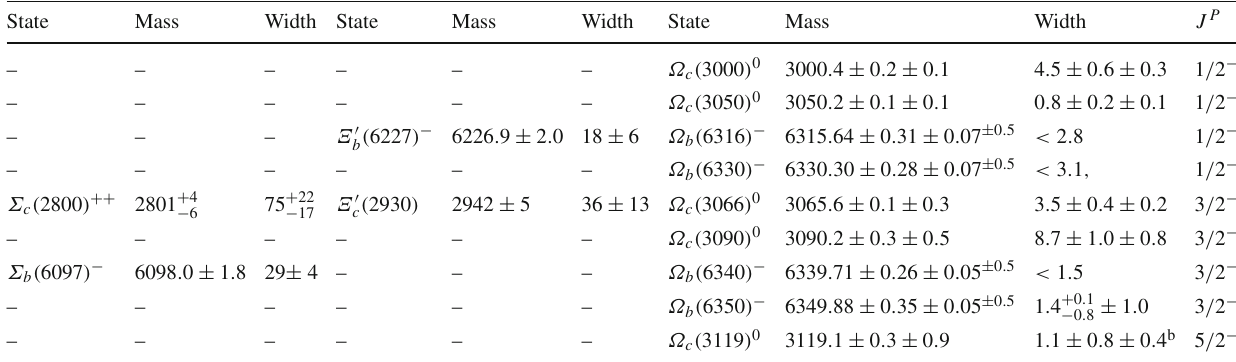
[1], with the proposed values Q